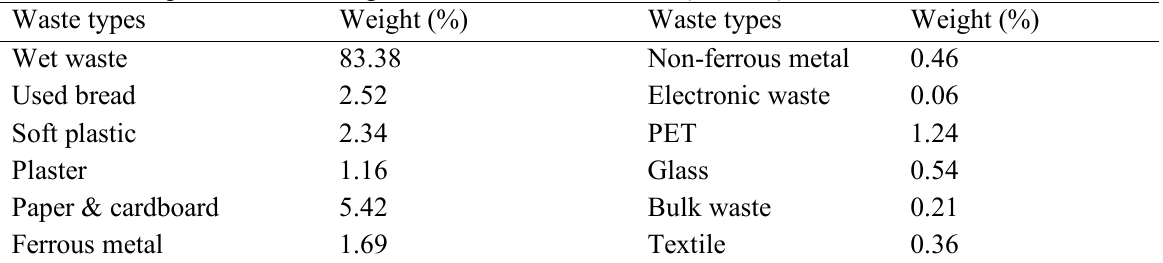
Table 3. Composition of MSW generated in Tehran in 2017 (TWMO) Waste